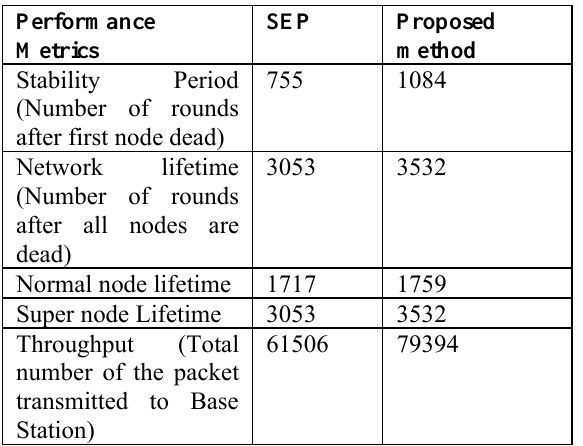
Figure 4. Number of Dead Nodes Vs Number of Round in Proposed Protocol Table 14. Performance